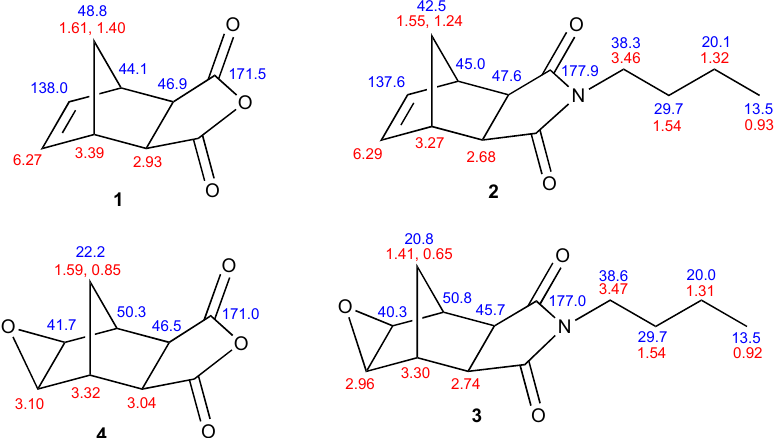
Figure 1. 1 H (in red) and 13 C (in blue) NMR chemical shift assignments for 1 [2], 2 , 3 , and 4 ( δ in ppm).